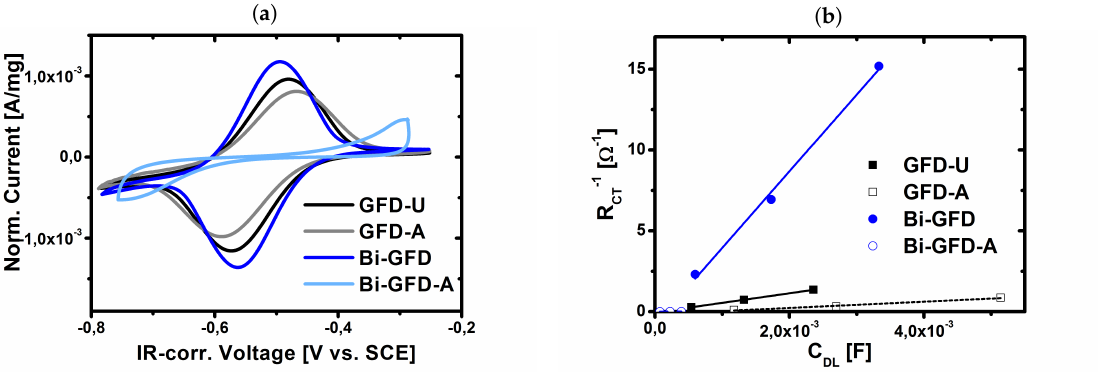
Figure 4. Evaluation of aged electrodes in three-electrode setup: CV ( a ) and normalized EIS results ( b